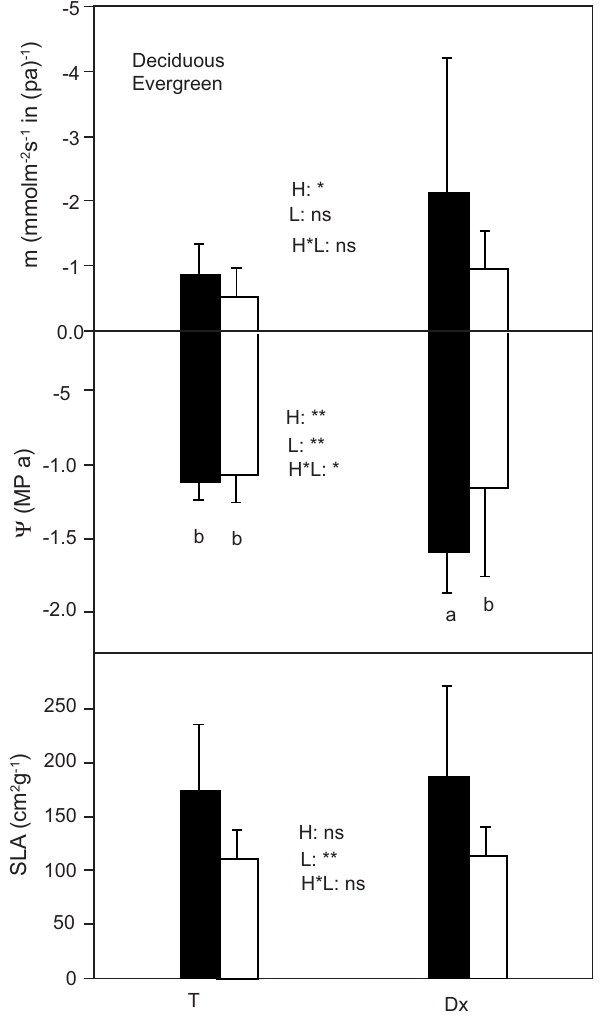
Figure 3. Leaf hydro-physiological and morphological charac- teristics. Effects of habitat (H), leaf phenology (L), and their interac - tion (H × L), on stomatal sensitivity (m), leaf water potential ( Y ) and specific leaf area (SLA) (mean ± SD, n = 3–5) of the tree species in two habitats. The ANOVA for Ψ is based on log-transformed data. See Figure 1 for other